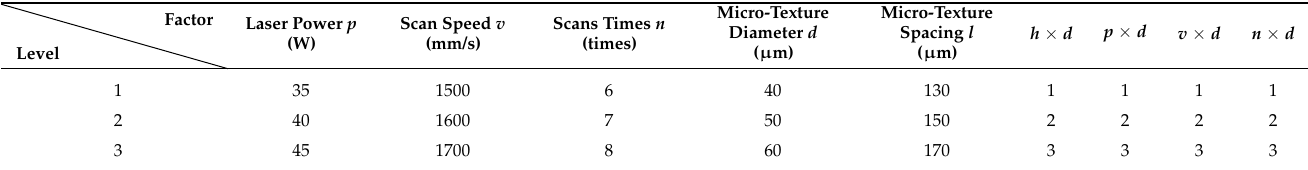
Table 2. Five-factor and three-level orthogonal